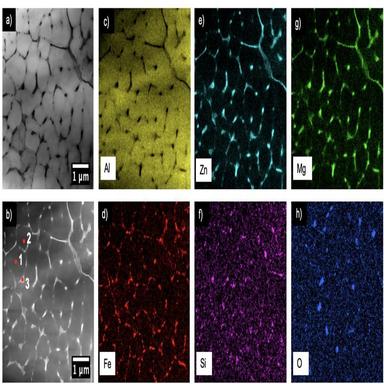
BF-STEM and HAADF-STEM micrographs of Al-14Zn-3Mg are presented in (a) and (b), respectively, and the corresponding EDXS maps are presented in (c-h). The compositional variation in at. % of different elements at three different points 1, 2 and 3 are tabulated noting that Si and Fe are present as impurities.